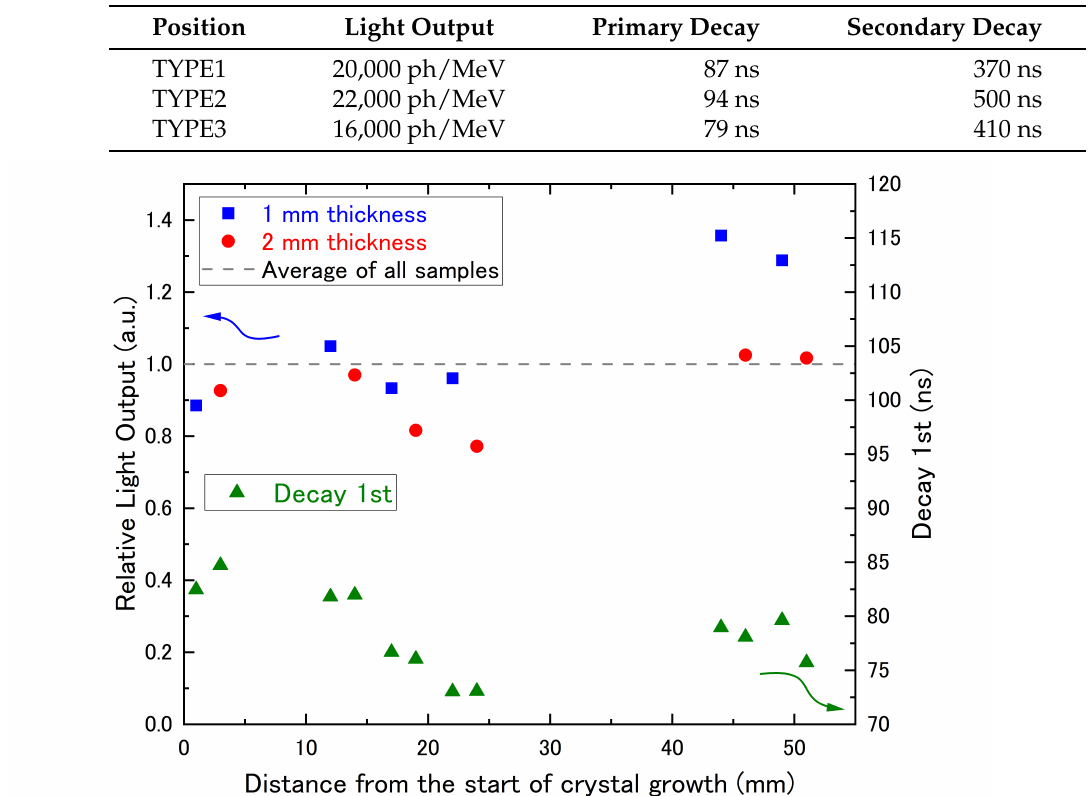
Table 1. Results of scintillation property measurements.